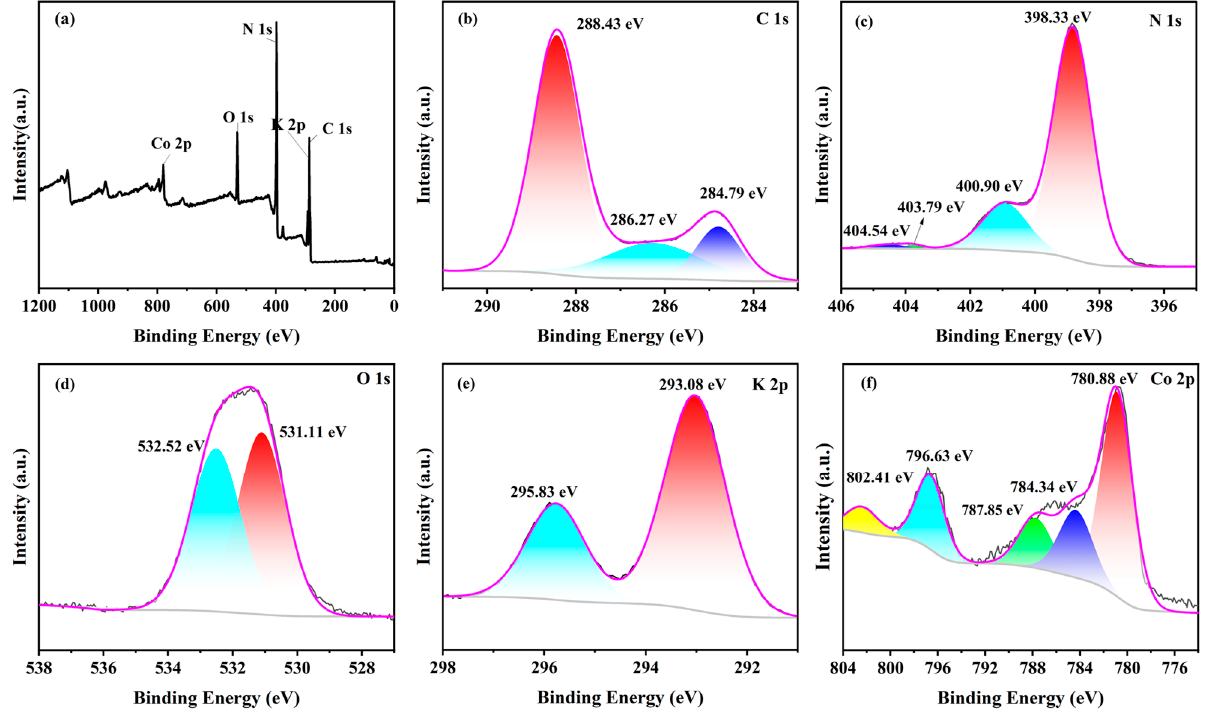
Figure 4. The XPS spectra of 9%Co-CNK-OH: ( a ) full spectrum, ( b ) C 1s, ( c ) N 1s, ( d ) O 1s, ( e ) K 2p, and ( f ) Co 2p.